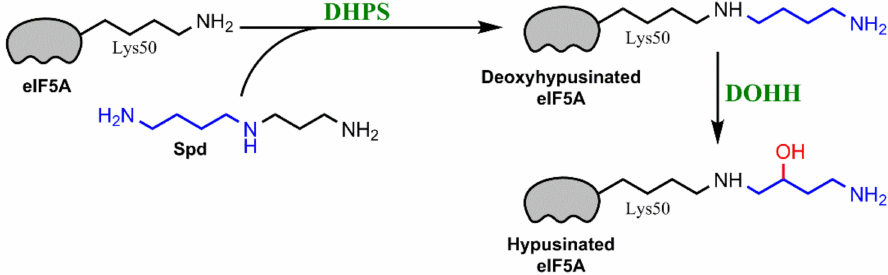
Figure 3. Spermidine serves as a substrate for a hypusination of eukaryotic translation initiation factor 5A (eIF5A). Lysine 50 residue of the latter is conjugated with the aminobutyl fragment from spermine by deoxyhypusine synthase (DHPS), and the resulting deoxyhypusinated factor undergoes oxidation by a deoxyhypusine hydroxylase